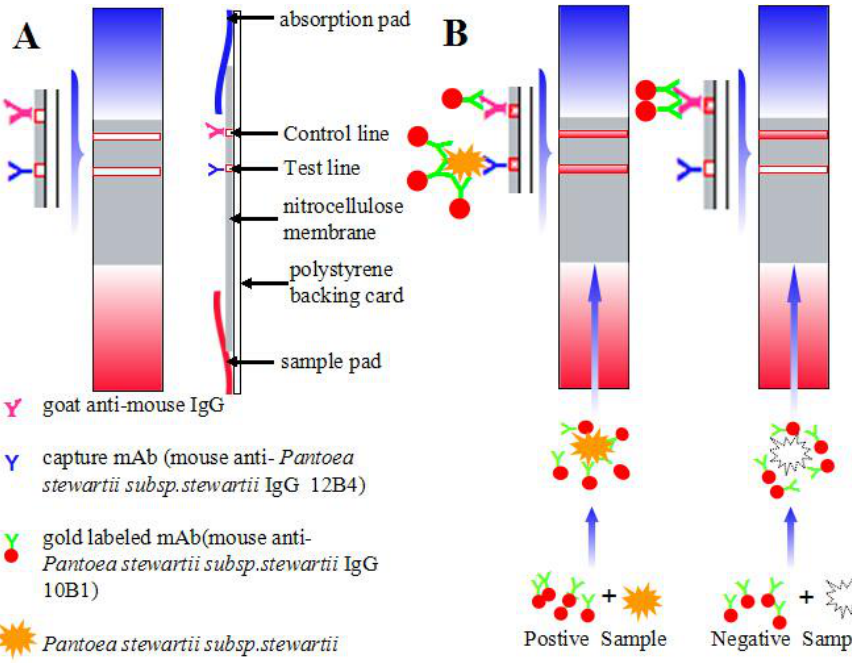
Figure 2. The schematic image of the assembled strip and the principle of the detection. ( A ) The schematic image of the assembled strip; ( B ) The principle of the detection method. A sample is positive for Pss if two lines appear: T and C. A sample is negative for Pss if only the